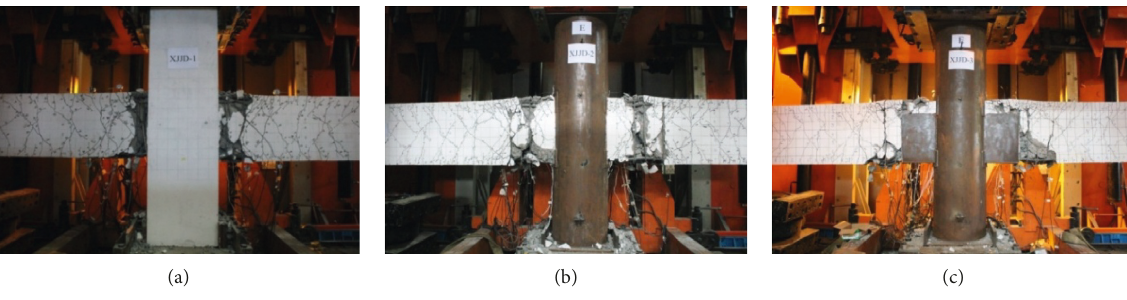
Figure 7: Failure modes of specimens: (a) XJJD, (b) SSJD, and (c) SUJD.